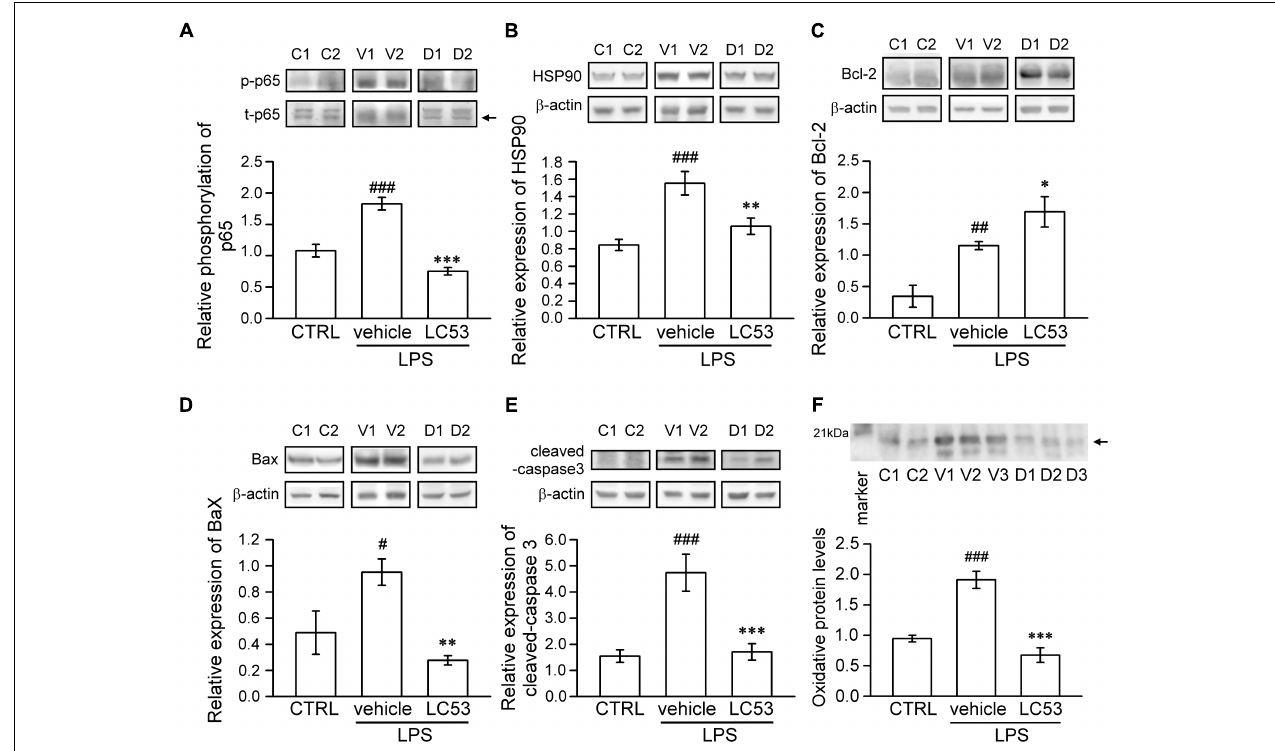
FIGURE 4 | LC53 exerted anti-inflammatory and anti-apoptosis properties during EIU. Phosphorylation of p65 (A) , HSP90 (B) , Bcl-2 (C) , Bax (D) , and cleaved-caspase-3 (E) in eye homogenates were analyzed using Western blot. (F) Eye homogenates were examined for the protein oxidation using Oxyblot. Primary antibody specific to DNP-moiety was used to target the oxidatively modified proteins in Western blot. The specific marker (21 kDa) was shown on the left side, which represented carbonylated-trypsin inhibitor from the mixture of standard proteins. The quantification values were presented as the mean ± SEM of results from 5 to 7 animals. Representative bands from 2 to 3 independent experiments were shown for each group: the control groups (C1, C2), vehicle-treated EIU groups (V1, V2, V3), and LC53-treated EIU groups (D1, D2, D3). C, CTRL: control; V: vehicle. # p < 0.05, ## p < 0.01, ### p < 0.001 compared with the control groups treated with normal saline; ∗ p < 0.05, ∗∗ p < 0.01, ∗∗∗ p < 0.001 compared with the EIU group treated with